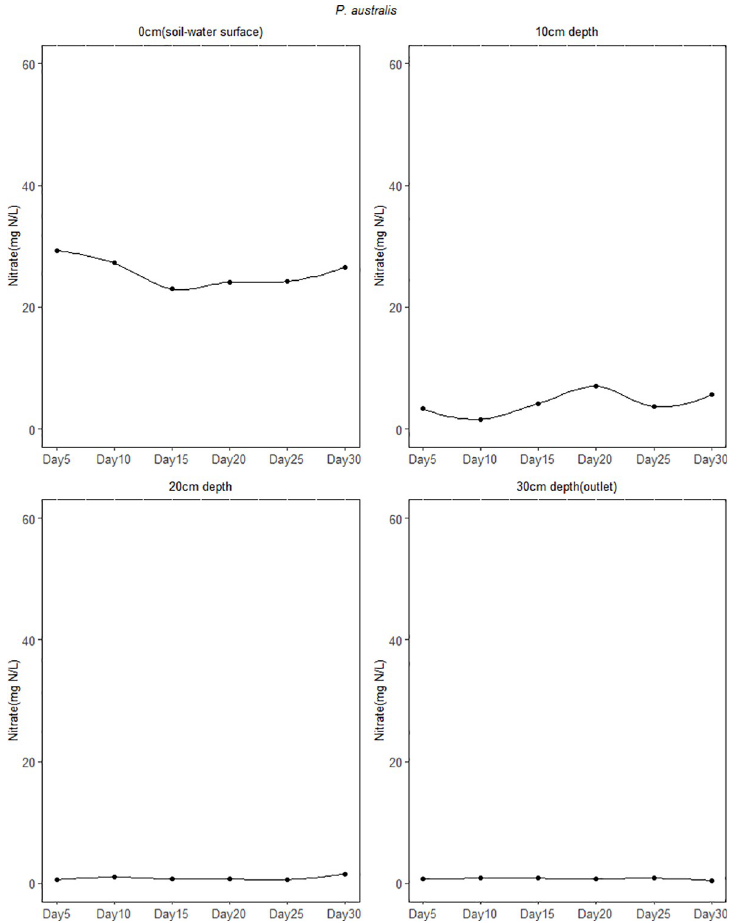
Fig 8. Temporal variation of NO (cid:0) australis